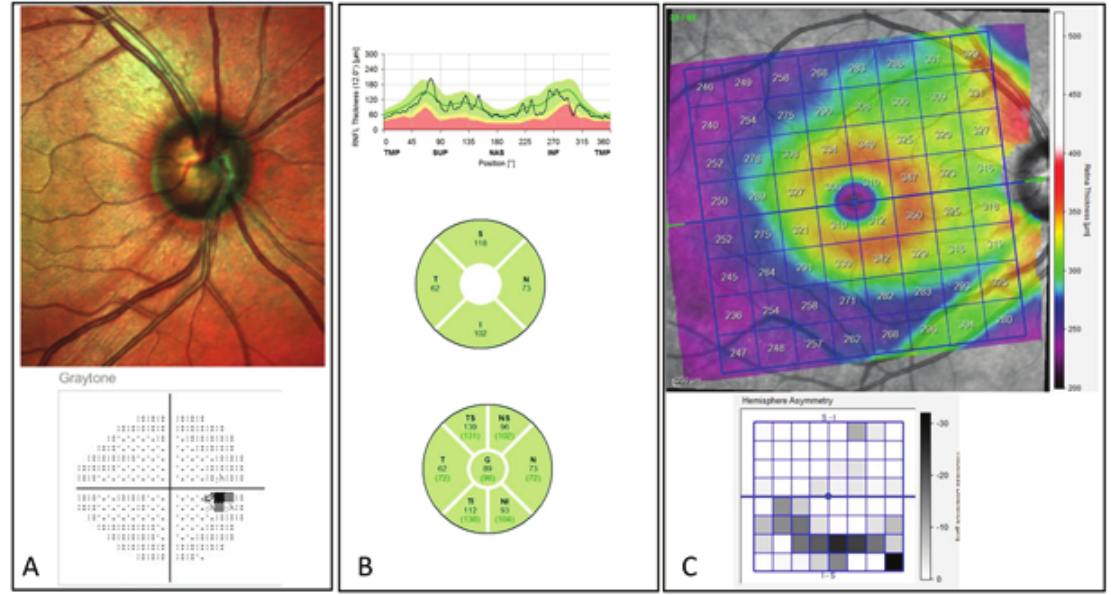
Figure 3. An early glaucoma case with normal VF (A) in which Spectralis RNFL Single report shows normal mean RNFL thickness values and normal sectoral value (B). Posterior Pole Thickness Map and Hemisphere Asymmetry Map shows area of thinning in the macular area corresponded to the location of narrow RNFL defect in optic disc